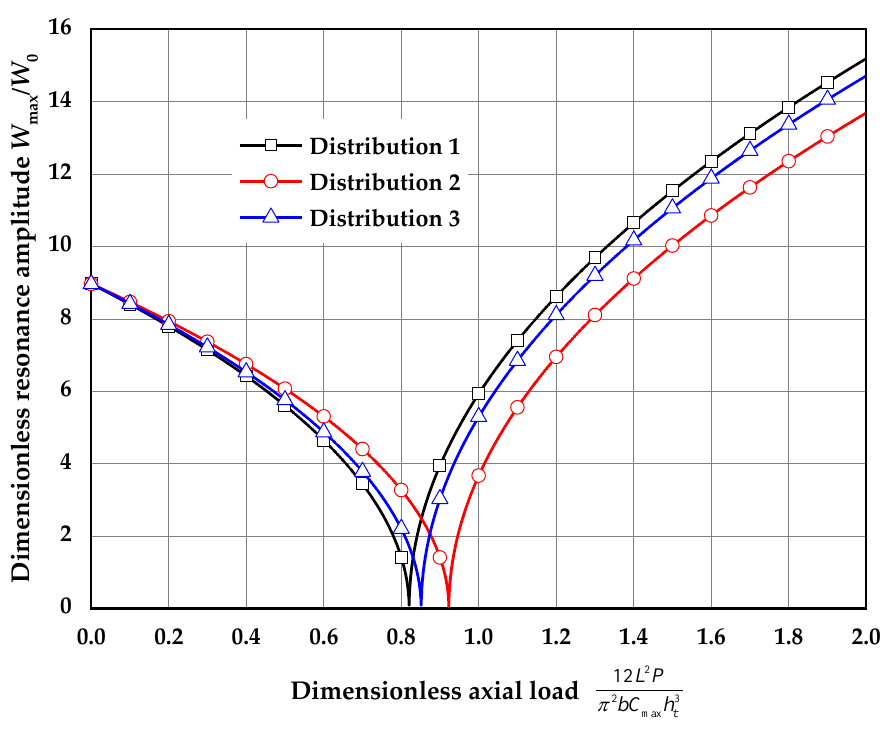
Dimensionless axial load Figure 11. Dimensionless resonance amplitude ( W max / W 0 ) – axial load ( 12 L 2 P ) curves π 2 bC max h 3 t ( m s = 0.5 I 0 L , W 0 = 0.01 h t , κ 0 = 0.5, R = 1 k Ω ). Shown in Figure 12 are the dimensionless optimal root mean square voltage output V rms ( a 33 )-axial load ( 12 L 2 P ) curves for different distributions of the core layer ( P ≤ P cr , e 311 W max π 2 bC max h 3 t m s = 0.5 I 0 L , W 0 = 0.01 h t , κ 0 = 0.5, R = 1 k Ω ). In the prebuckling procedure, it can be seen that the optimal RMS voltage decreases as the axial load increases, and there is little difference between the optimal RMS voltage of distribution 1 and distribution 3, and distribution 2 has the largest optimal RMS voltage. In the postbuckling procedure, as the axial load increases, the optimal RMS voltage increases. Distribution 1 has the largest optimal RMS voltage, and distribution 2 has the smallest optimal RMS voltage among these three type distributions. (cid:112) Shown in Figure 13 are the dimensionless natural frequency ( ( ω n L 2 / h t ) 12 ρ max / C max )– porosity coefficient ( κ 0 ) curves for different distributions of the core layer ( m s = 0.5 I 0 L , W 0 = 0.01 h t , R = 1 k Ω , P = 0). The influence of the porosity coefficient of the sandwich layer on the vibration frequency of the composite beam is also significant. In the figure, for the same value of the porosity coefficient ( κ 0 ), the mass of the three types of distribution is equal. It can be found that the vibration frequencies of distribution 1 and distribution 3 decrease rapidly with the increase in the porosity coefficient, while the decrease in the vibration frequency of distribution 2 is not obvious. In addition, for the same porosity coefficient, the vibration frequency of distribution 2 is the largest, the vibration frequency of distribution 3 is the second largest, and the vibration frequency of distribution 1 is the